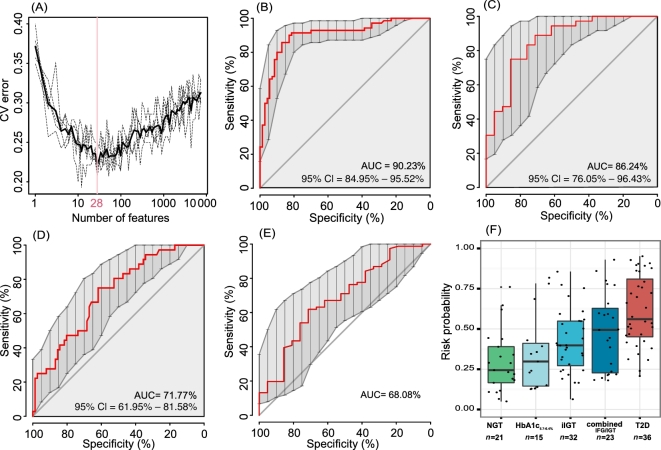
Random forest classification based on untargeted lipidomic profiling. (A) Distribution of 5 trials of 10-fold cross-validation error in random forest classifiers. The model was trained using relative intensity of the detected features from both positive ion mode and negative ion mode in the training set of normal glucose tolerant and type 2 diabetes patients (n = 70 and 70). The black solid curve indicates the average of the 5 trials (dash lines). The pink line marks the number of selected features in the optimal set. (B) Receiver operating characteristic curve and area under the ROC curve for the training set. (C–E) ROC and AUC for validation set with NGT and T2D (n = 21 and 36), prediabetes and T2D (n = 76 and 36), and NGT and prediabetes (n = 21 and 76), respectively. (F) Box-and-whisker plot presents the risk probability of developing T2D among the validated NGT (n = 21), subgroups of prediabetes including HbA1c5.7–6.4% (n = 15) to iIGT (n = 32) to combined IFG/IGT (n = 23), and T2D (n = 36) according to the RF model.